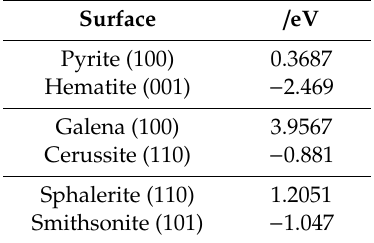
Table 3. The calculated Femi level of the minerals